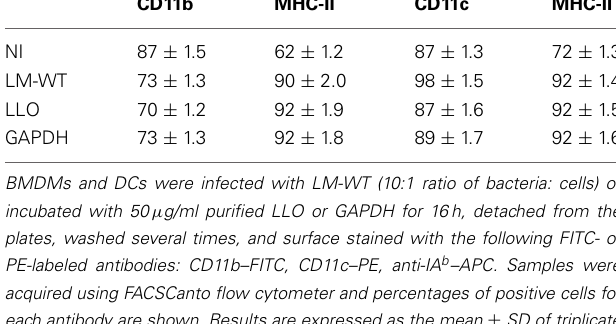
homogenates of popliteal lymph nodes after hind foot pad inoculation with 30 μ g LM-lysate. Cells were stimulated with LLO, GAPDH, or LM-lysate. Results show [ 3 H]-thymidine incorporation in triplicate samples of T cells. (C) 3D model of GAPD 1 − 22 peptide showing the MHC-I binding sequences in pink and the MHC-II binding sequences in yellow. (D) 3D structure of LLO showing the MHC-I and MHC-II epitopes in the C57BL/6 mouse model.